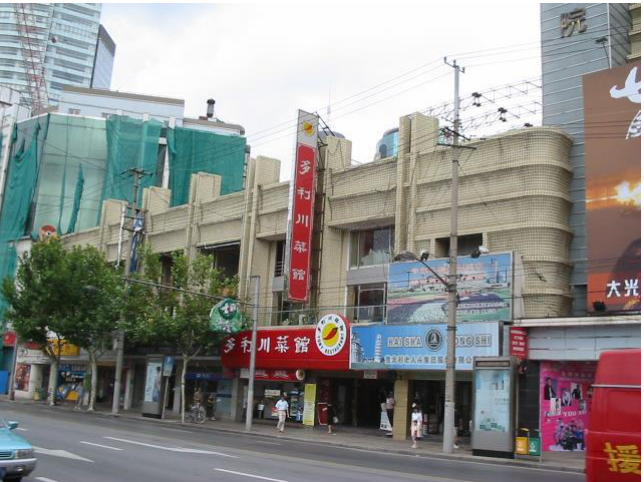
Figure 22. Recent view of the Grand